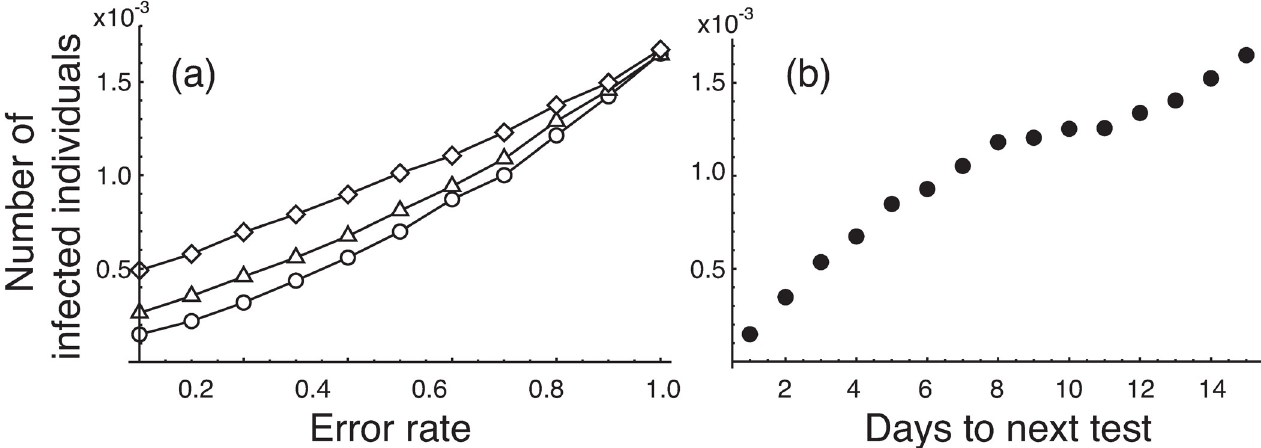
Fig 4. Risks in Group B in various measurement scenarios. (a) Risks in Group B with different test systems and different test error rates. The risk with the test system with daily PCR testing only ( � ) was the lowest, that with daily antigen testing only ( 4 ) was the second lowest, and that with an additional PCR test for individuals testing positive for antigens ( � ) was the highest. In all simulations, infected individuals showing symptoms (state Is ) are quarantined daily. (b) The risk with different test frequency. Only PCR testing with 0% error was used for the test. Numbers on the horizontal axis indicate the number of days to the next test. For example, a number 2 means that the test frequency was every 2 days. In all test frequencies, the first test on arrival (day 0) at the destination is conducted at day 0. At up to 7-day frequencies, more than two tests were conducted within the 14 days’ isolation. After 8 days, tests were conducted two times, and at 15 days, testing is only once at day